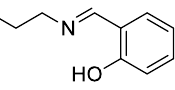
Figure 1. Structure of the ligand H 2 L.